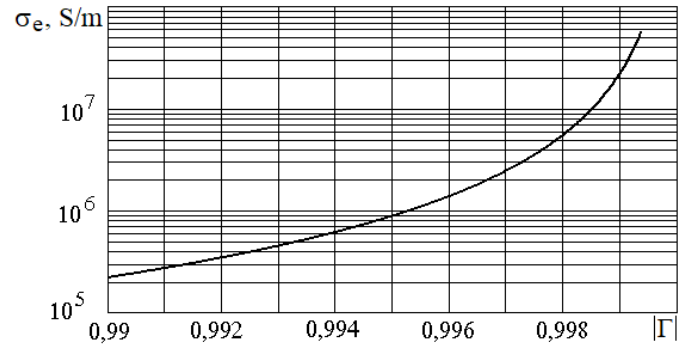
Fig. 3. Dependence of equivalent surface conductivity on the module of reflection